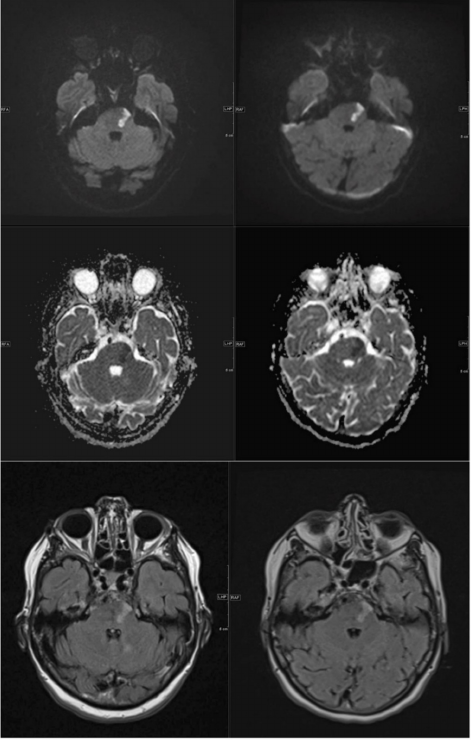
Figure 7. Left images from top to bottom axial 1.5 T DWI, ADC and FLAIR sequence with sharply delineated, demarcated, subacute pons infarct on the left. Right side, corresponding axial 0.55 T DWI, ADC and FLAIR sequence at the same slice localization with equivalent infarct morphology and thus identical diagnostic